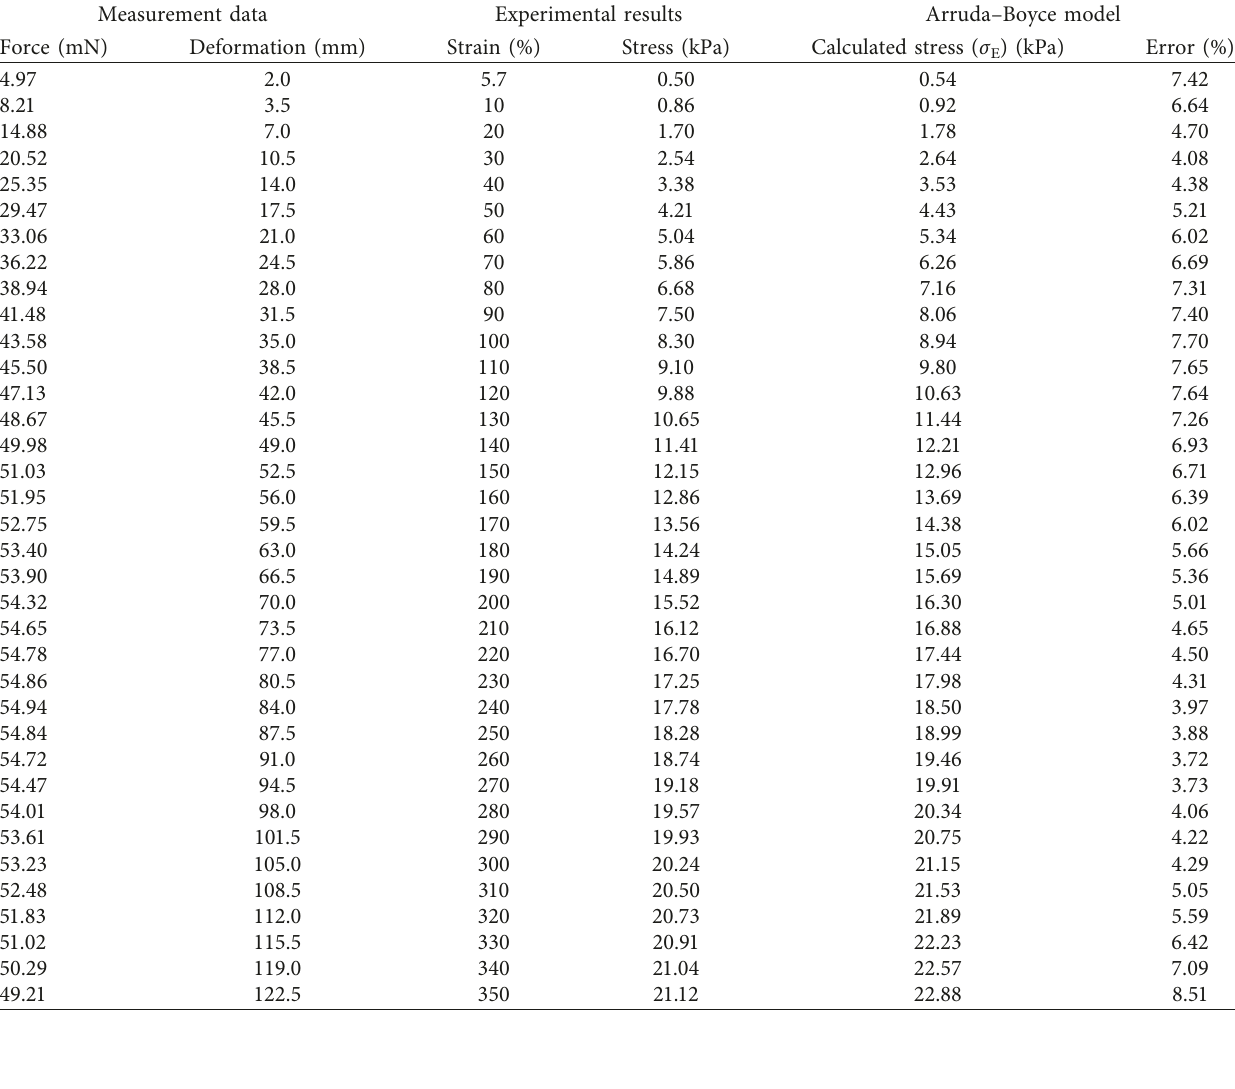
Table 1: Comparison of the tensile stress calculation data with experimental data obtained in the uniaxial tensile test. Measurement data